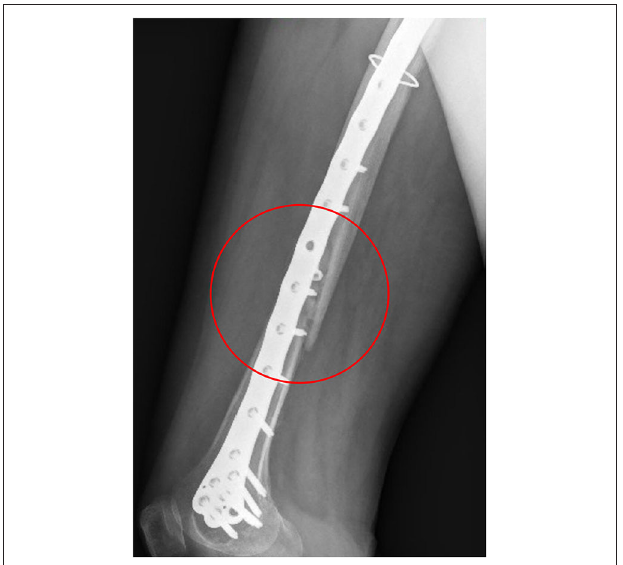
FIGURE 11 | X-ray image taken after 2 months from the surgery. The non-consolidation of the bone fracture is pointed